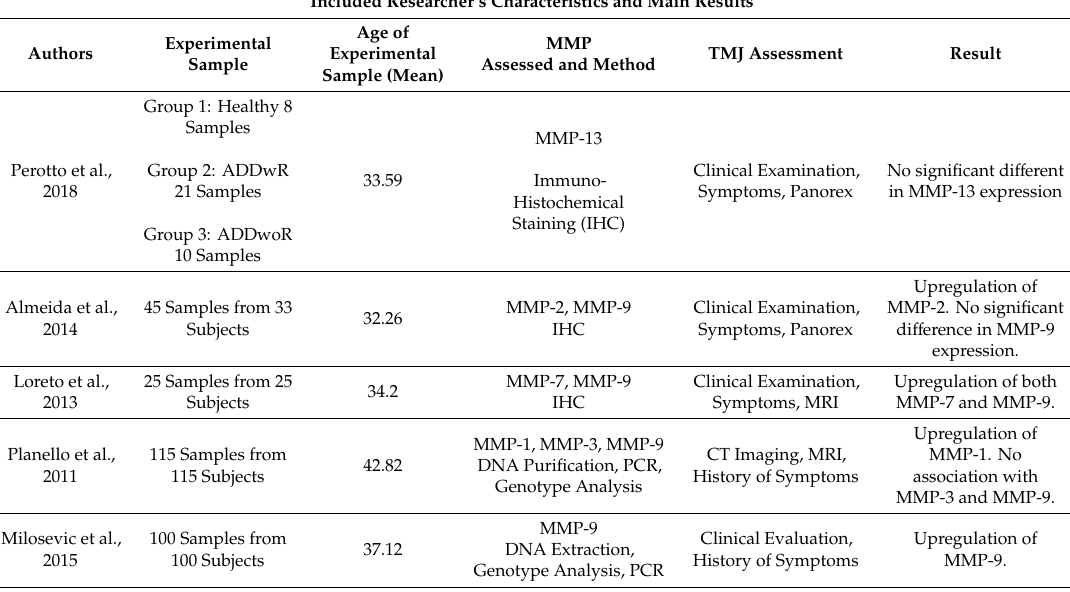
Table 1. Studies that fit the inclusion criteria and published within the past 10 years [11,13–17]. Anterior disc displacement with reduction (ADDwR); anterior disc displacement without reduction (ADDwoR); matrix metalloproteinases (MMP); temporomandibular joint